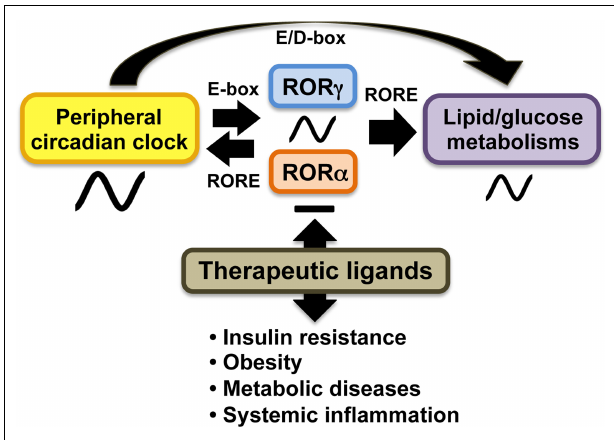
FIGURE 2 | In peripheral tissues, RORs function as intermediate regulators providing a link between clock proteins and their regulation of lipid and glucose metabolism. The oscillatory pattern of expression of ROR γ is regulated by circadian clock proteins Bmal1 and Clock or Npas2 through E-box, whereas ROR α does not exhibit a strong oscillatory pattern of expression. In turn, ROR γ activates expression of several clock genes through ROREs together with ROR α . Both ROR α and ROR γ regulate the circadian pattern of expression of target genes involved in lipid/glucose metabolism. ROR (ant)agonists may modulate the amplitude of peripheral clock oscillation of these metabolic outputs and might be useful in the treatment of insulin resistance, obesity, and tissue